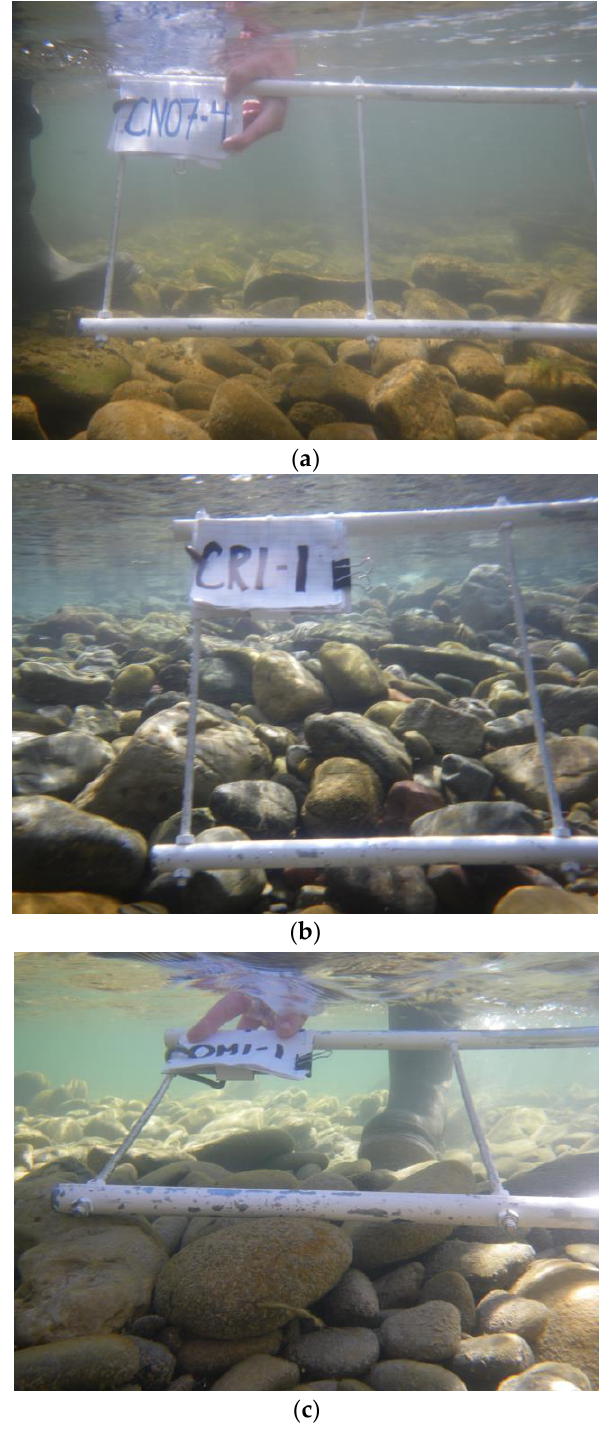
Figure 3. Sample photographs of river-beds: ( a ) Crowsnest River, ( b ) Castle River and ( c ) Oldman River.